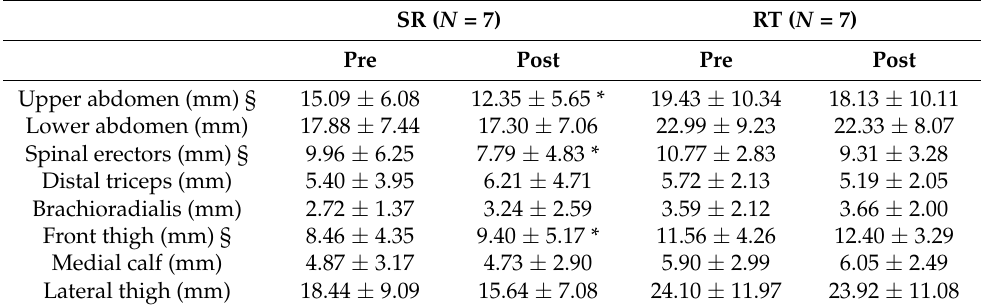
Table 4. Ultrasound results of spot reduction (SR) and resistance training (RT) groups.